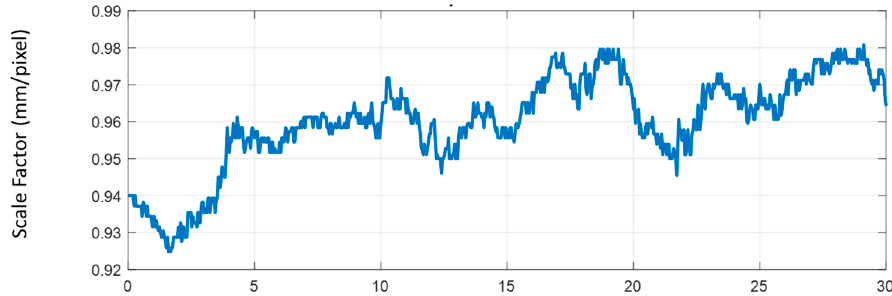
Figure 6. Change in the scale factor over time.